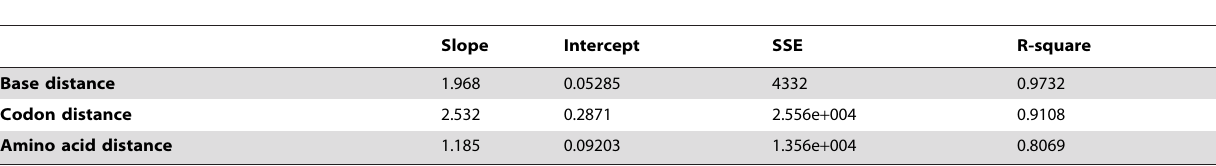
Table 1. Results of least squares fitting between vector distance of genome pairs and their GC content difference.